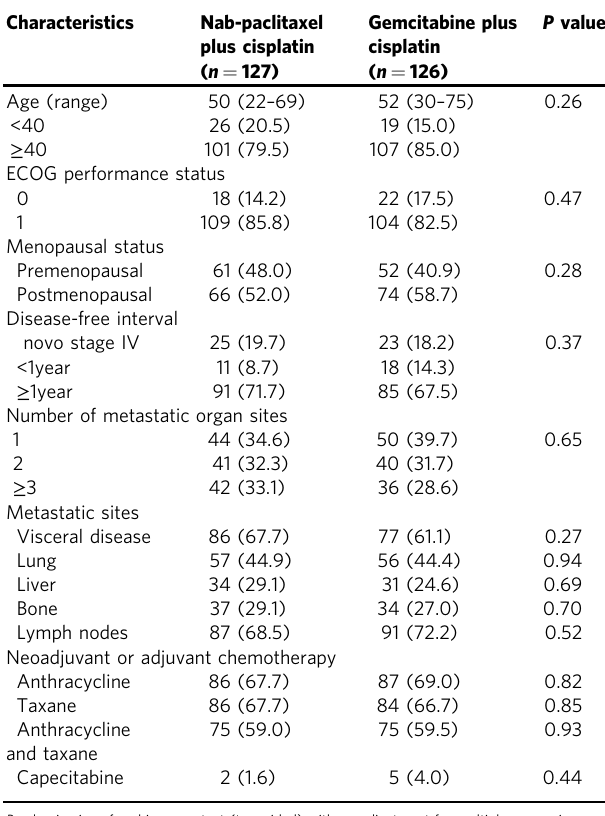
Table 1 Patient characteristics. Characteristics